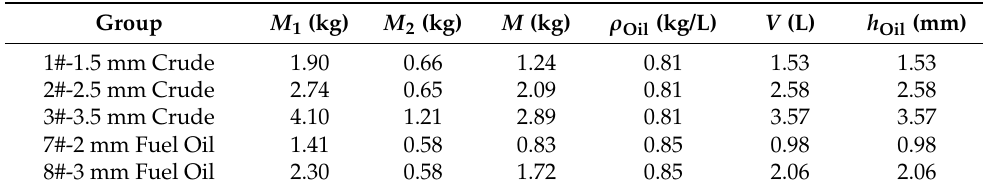
Table 2. Data of the heavy-oil film experiment groups.